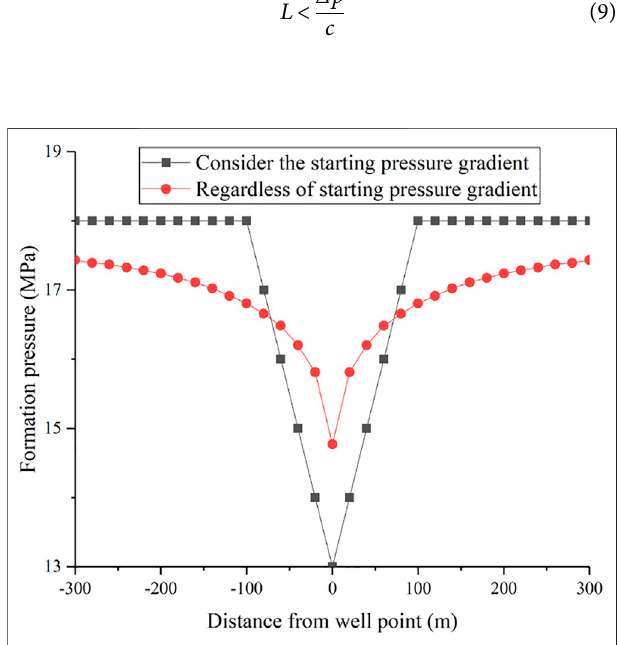
FIGURE 7 | Variation characteristics of formation pressure around